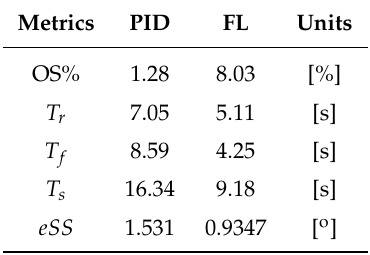
Table 5. Pitch Time Response Results in Underwater Experiments for PID and FL